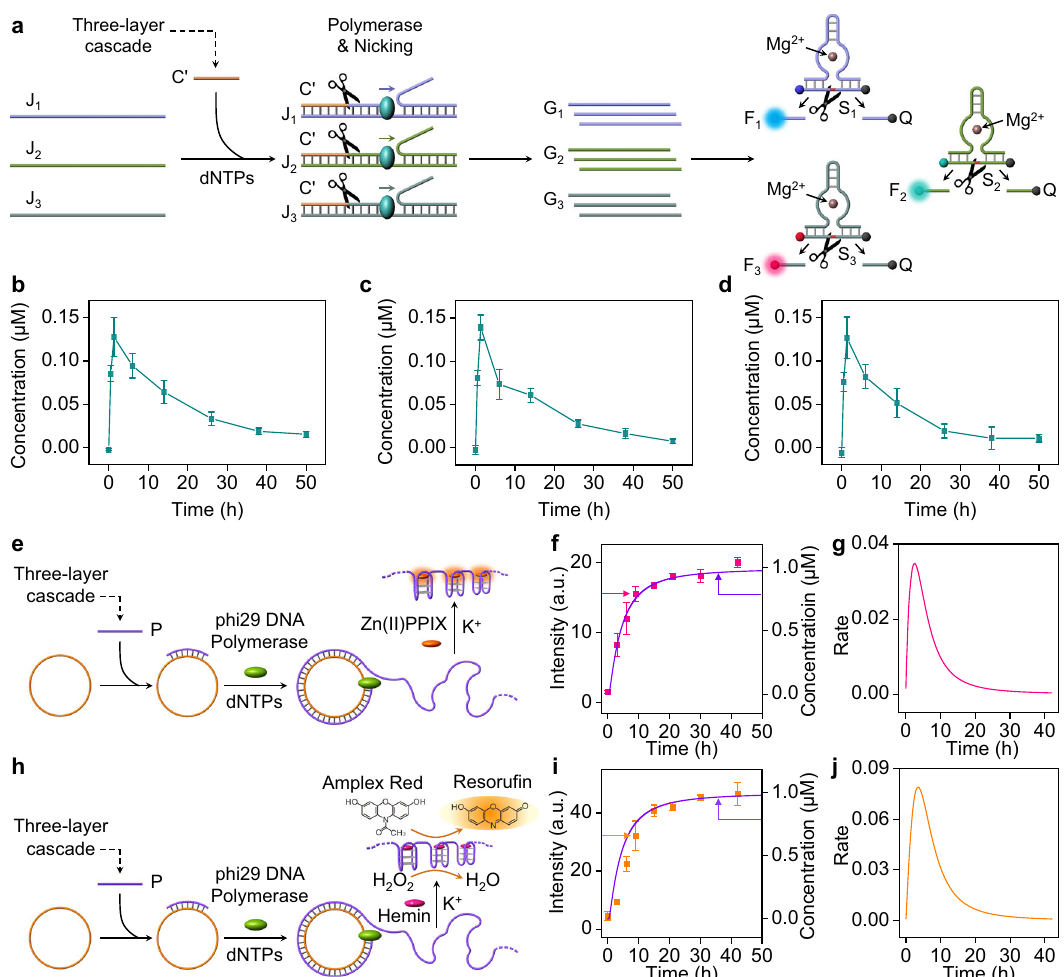
Fig. 4 | Conjugation of the transient three-layer DNAzyme cascade to sub- sequent biocatalytic processes. a Coupling of the three-layer cascade to a poly- merase/nicking machinery consisting of promoter-triggered three scaffolds J 1 -J 3 yieldinginthepresenceofdNTPs,thetransientsynthesisofthreeDNAzymecoded strands, G 1 -G 3 . The dynamic formation of the coded strands is followed by the fl uorescence changes generated by the DNAzyme catalyzed cleavage of the sub- strates S 1 -S 3 . Transient concentration changes of the DNAzyme oligonucleotides: ( b )-DNAzyme G 1 , ( c )-DNAzyme G 2 , ( d )-DNAzyme G 3 . e Coupling of the three-layer cascade to the RCA process yielding Zn(II)-PPIX-functionalized fl uorescent G-quadruplex wires. f , g , ( f )-Time-dependent fl uorescence intensities of the Zn(II)- PPIX-generated G-quadruplex wires (square dots), and time-dependent con- centrationsofthepromoterstrandPgeneratedbythecascade(purplesolidcurve).